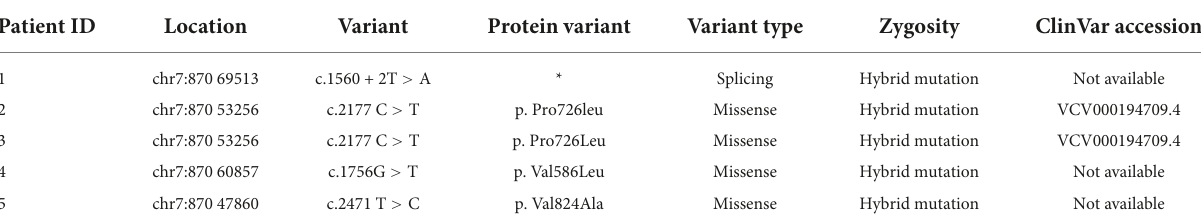
TABLE 3 Patients with pathogenic ABCB4